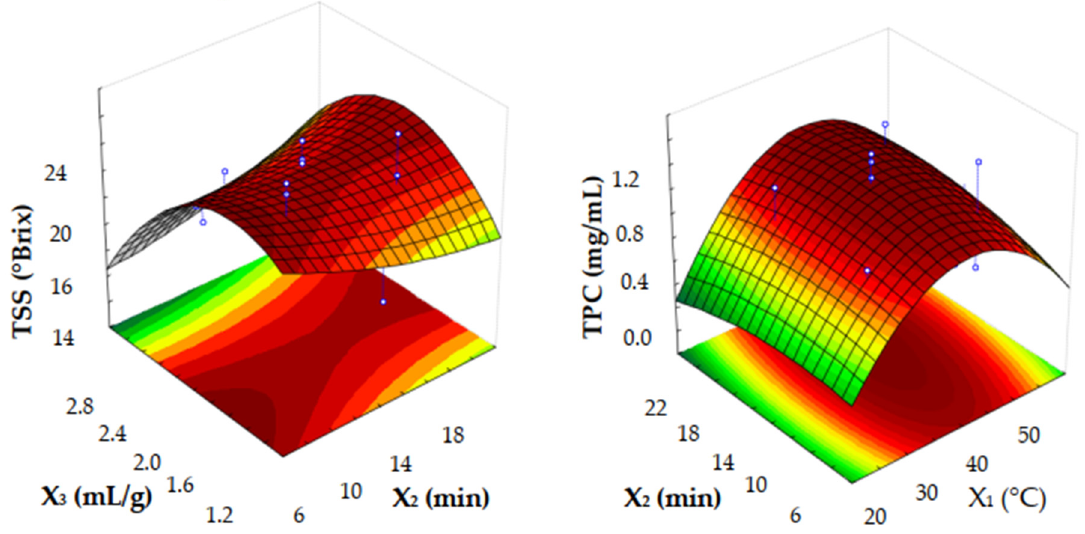
Figure 4. Response surface plots showing the effects of liquid–solid ratio (X 3 ) vs. time (X 2 ) and time (X 2 ) vs. temperature (X 1 ) on TSS and TPC, respectively, in UAE carob